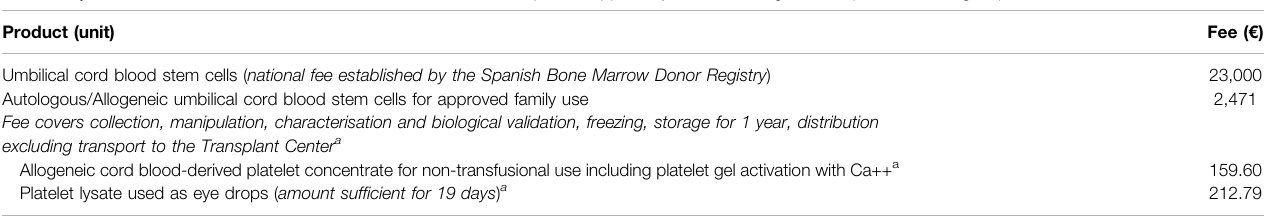
TABLE 3 | Reimbursement fees for the transfer of one unit of CB component applied by Banc de Sang i Teixits (www.bancsang.net). Product (unit) Fee ( €